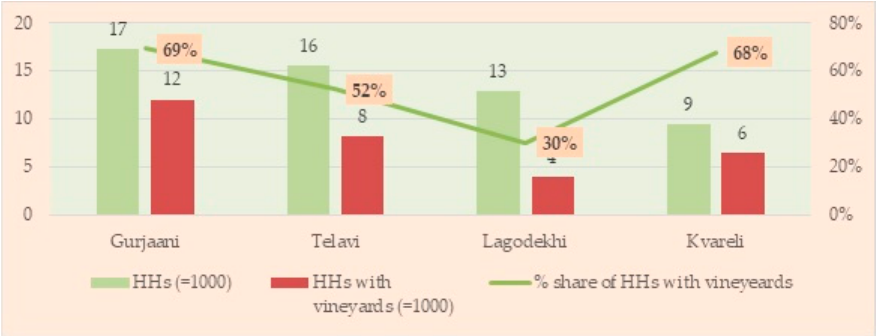
Figure 5. Number of HHs with registered firm business relative to total number of HHs.